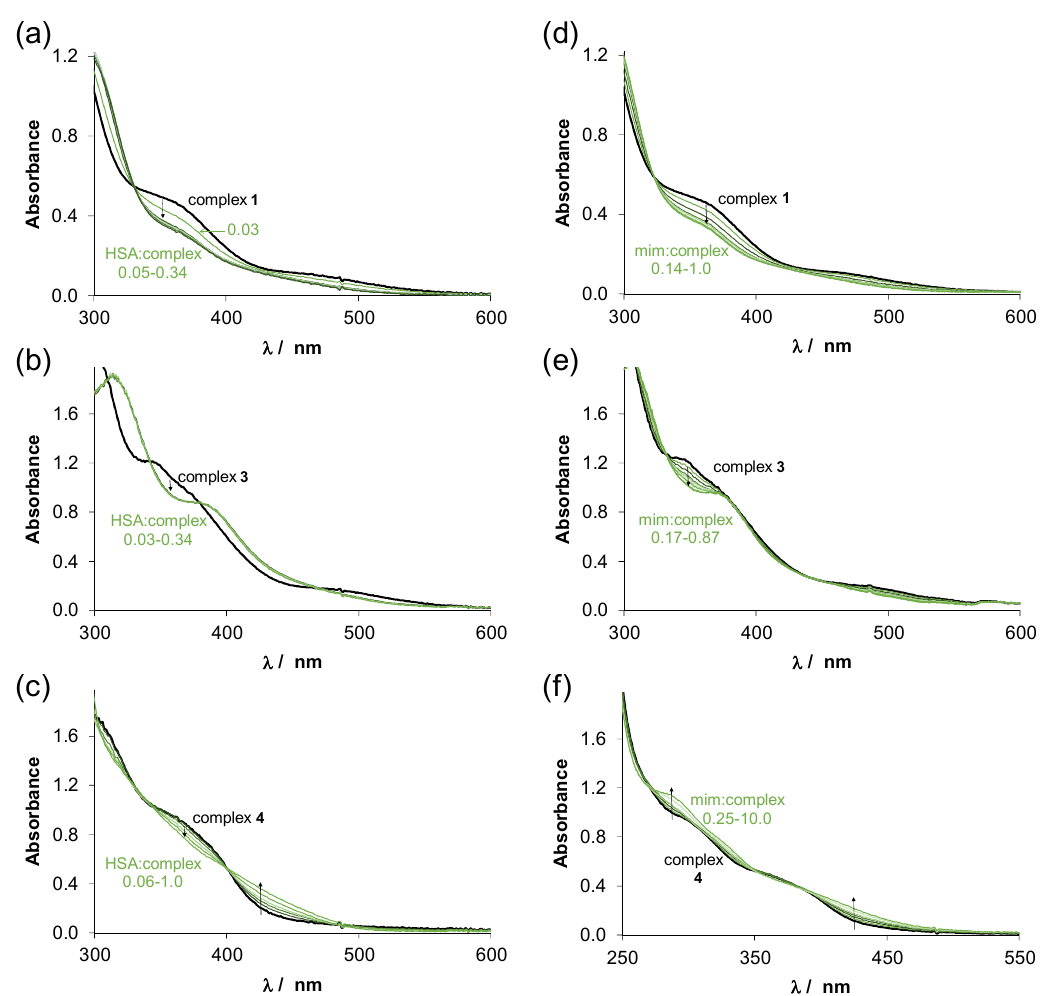
Figure 7. UV-vis absorption spectra recorded for ( a , d ) complex 1 , ( b , e ) complex 3 and ( c , f ) complex 4 in the presence of various equivalents of HSA or mim, respectively at pH = 7.4. The numbers indicate the range of the c HSA / c complex or c mim / c complex ratios. In case of PTA complexes 24 h incubation time was used. { T = 25.0 °C, pH = 7.40 PBS’ buffer, c complex = 210 μM, c HSA = 6.3–71.4 μM or c mim = 29–210 μM ( a , b , d , e ); c complex = 116 μM, c HSA = 6.3–71.4 μM or c mim = 29–1160 μM with 8% ( v / v ) DMSO ( c , f ); l = 1 cm}.